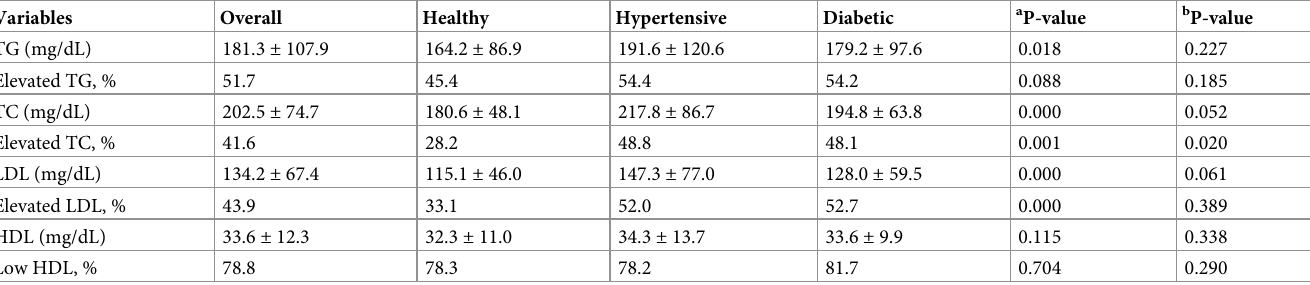
The overall prevalence of dyslipidemia was 89% with no significant difference between male (90.1%) and female (85.7) subjects ( Table 2 ). When participants were classified into healthy, hypertensive and diabetic groups, the prevalence of dyslipidemia was 84.3%, 91.8% and 88.7%, respectively ( Table 2 ). The levels of lipid profile and prevalence of lipid abnormalities were higher in hypertensive and diabetic individuals than in the control individuals. Overall, hyper- triglyceridemia prevalence was 51.7%, hypercholesterolemia 41.6%, high LDL 43.9% and low HDL 78.8% among the participants ( Table 3 ). Low HDL levels were the main prevalent dysli- pidemia among the study subjects. The prevalence of isolated hypertriglyceridemia, isolated Table 3. Levels and prevalence of elevated lipid markers in different